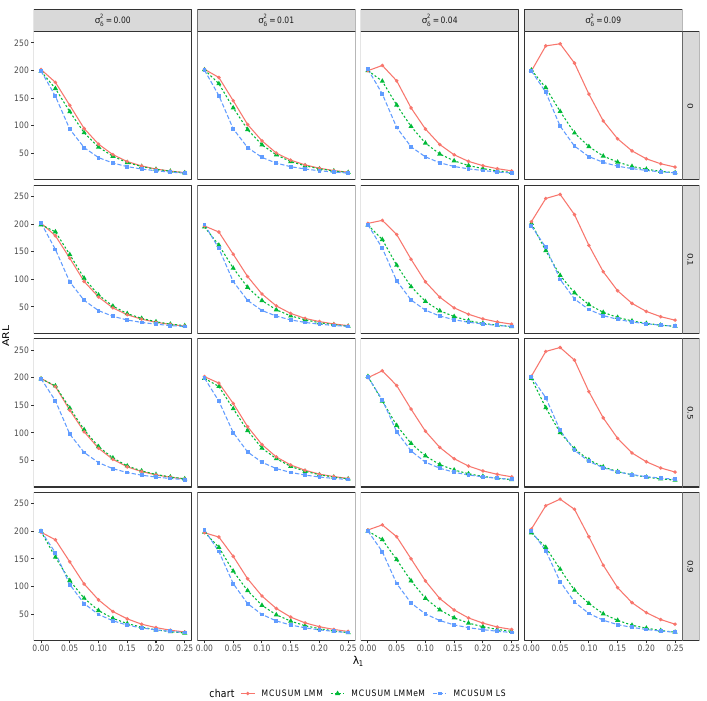
Figure 5. Effect of ignoring measurement errors and/or random effects on ARL performance for MCUSUM control charts under different shifts in